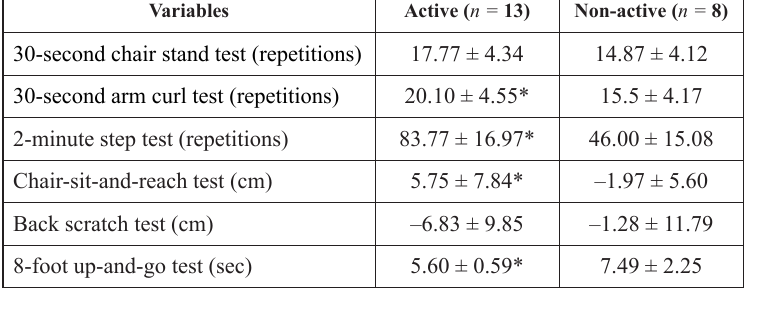
Table 3. Basic descriptive psychological pa - rameters (means ± standard deviations)